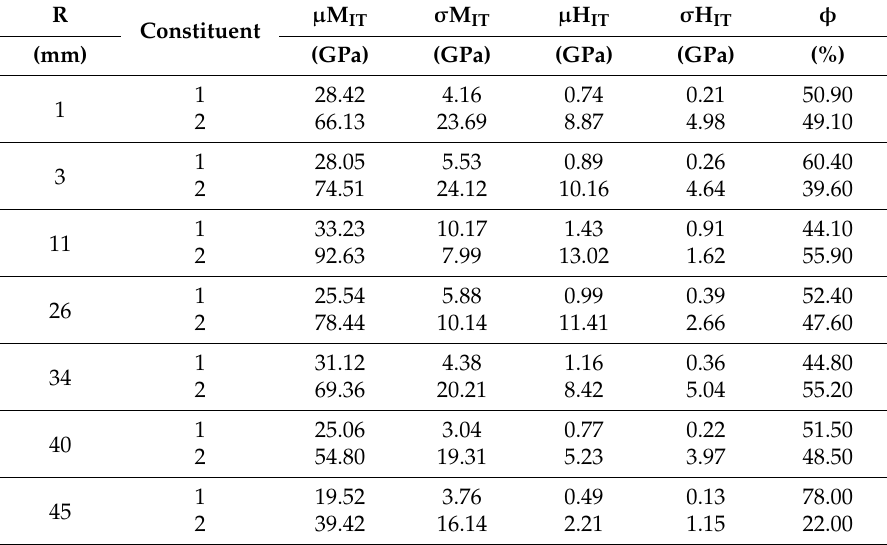
Figure 26. Variation in hardness H IT , indentation modulus E IT and constituent content across wall. Table 2. Hardness H IT, indentation modulus E IT and fractional content ϕ of tested material constituents.